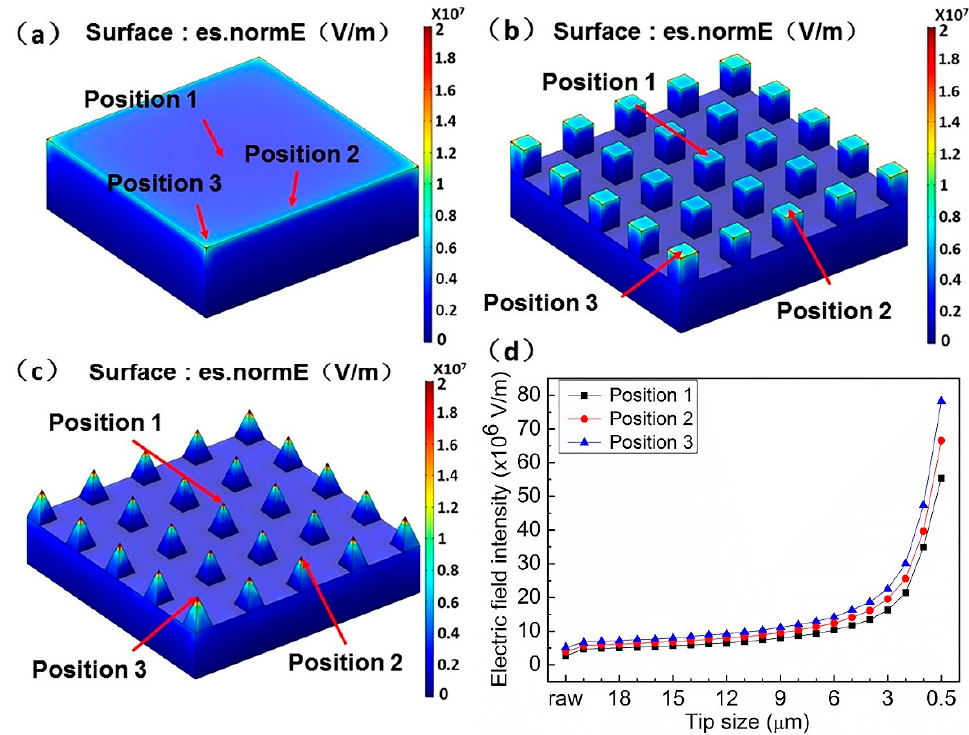
Figure 5. ( a ) The electric field strength distribution of the model of raw VACNT film. ( b ) The electric field strength distribution of the model of the arrays with a tip size of 20 µ m. ( c ) The electric field strength distribution of the model of the nanocone arrays with a tip size of 500 nm. ( d ) The electric field strength calculation results of the middle point (Position 1, the center point of the upper surface of the center array corresponds to the center point of the upper surface of VACNT), edge-point (Position 2, the center point of the upper surface of the third array of edges corresponds to the position of the same coordinates of VACNT), and the center point (Position 3, the center point of the upper surface of the corner array corresponds to the same coordinate position of VACNT) of the top surface of the cone arrays of tip size from 0.5–20 µ m and the raw